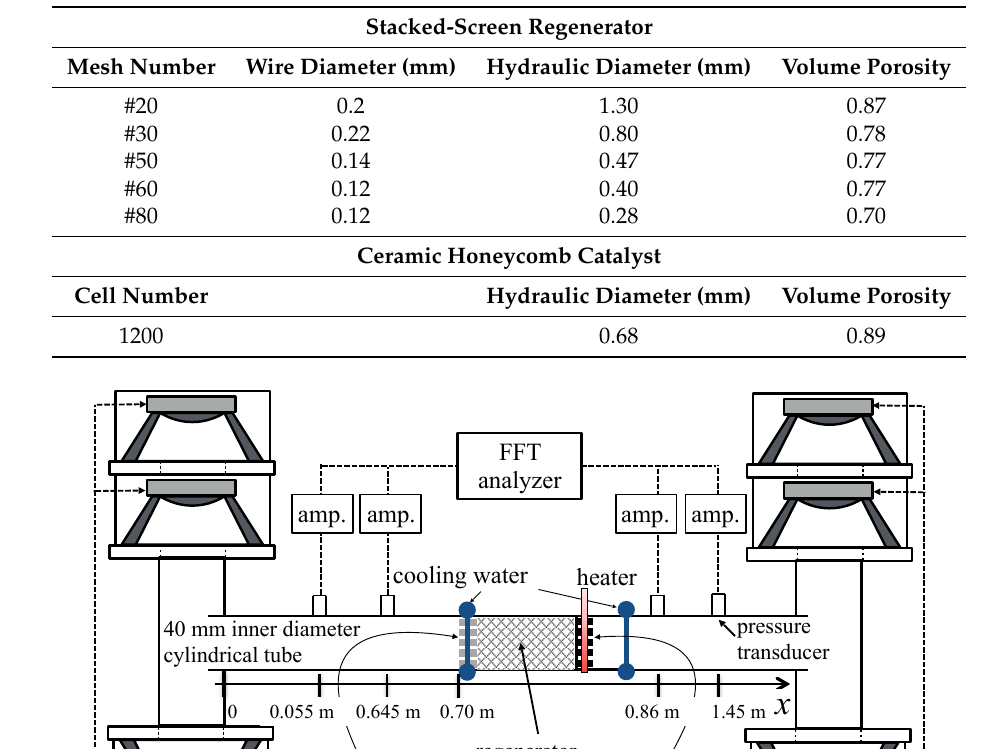
Table 1. Geometrical properties of regenerators.